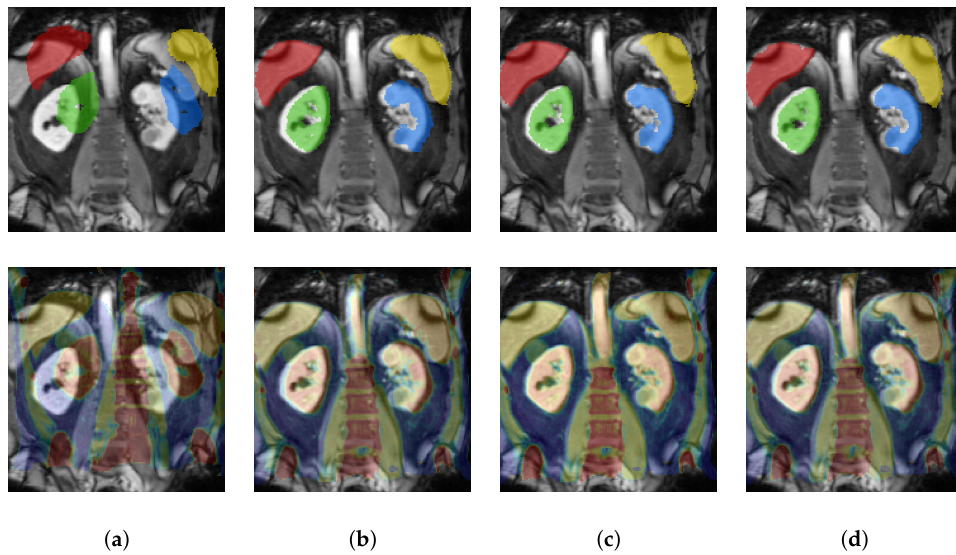
Figure 4. Qualitative results of our proposed cycle discrepancy approach FeatCNN + Cycle Dis- crepancy ( c ). We visualise the comparison to initial ( a ) before warping as well as to the methods FeatCNN + MI Loss ( b ) and FeatCNN + Label Loss ( d ) (coronal slices). The top row shows the fixed MRI and (warped) moving labels. The bottom row visualizes the (warped) moving CT and a jet colourmap overlay of the fixed MRI